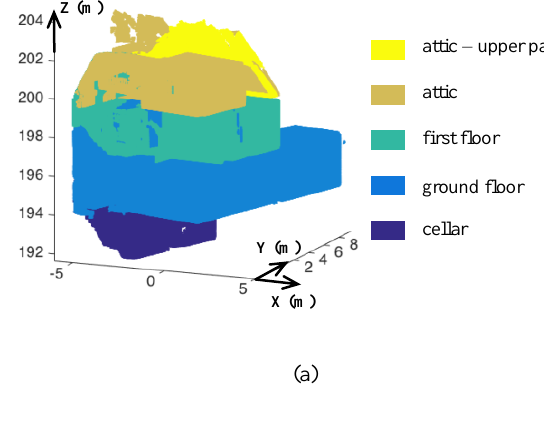
Figure 3. Distribution of points along Z axis: (a) point cloud; (b) corresponding